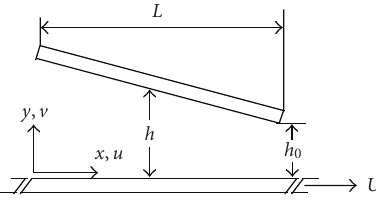
Figure 1: A schematic model of the thin film air bearing